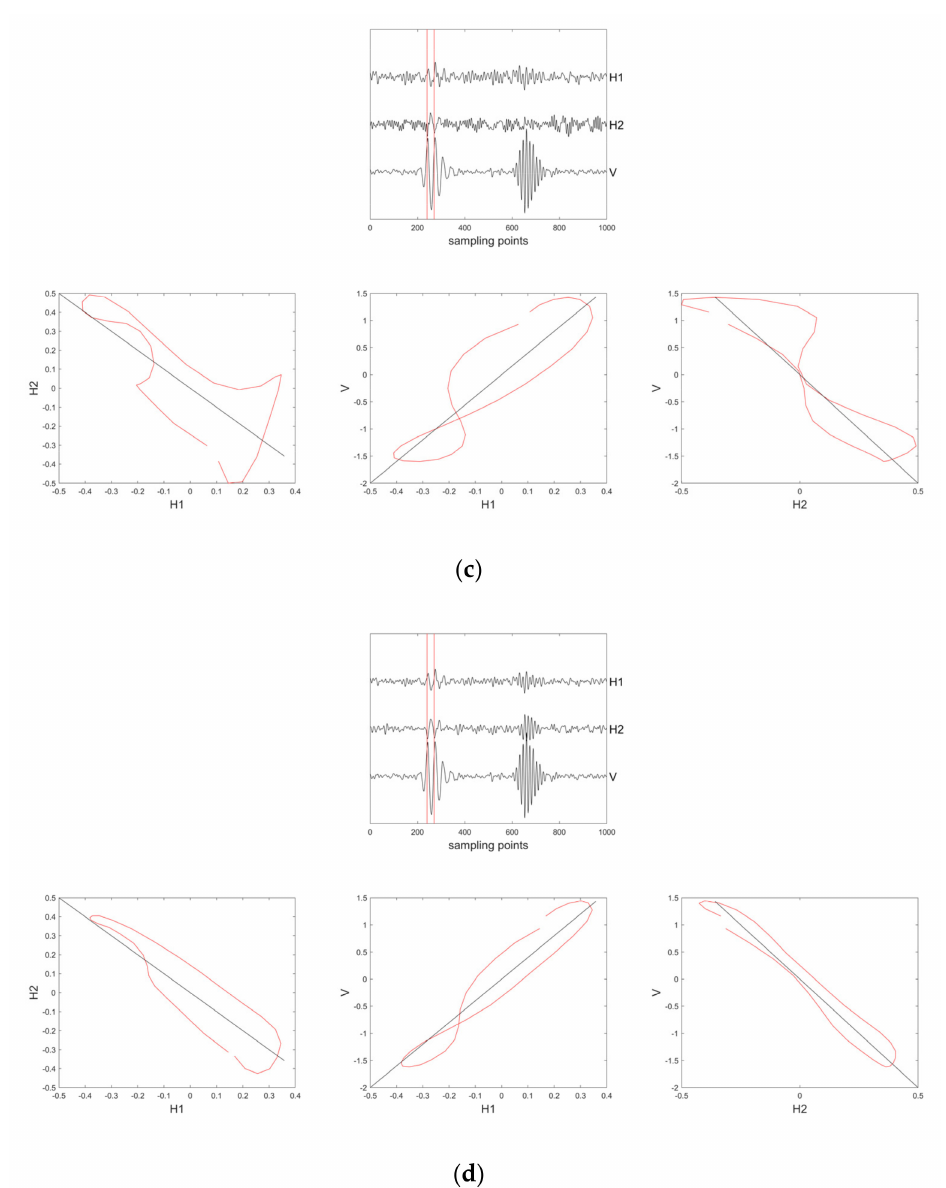
Figure 8. Comparison of hodogram analysis of the synthetic data. ( a ) The synthetic data without noise (the two red lines are the time window of the hodograms) and the hodograms of the three-component data. ( b ) The synthetic data with noise (the two red lines are the time window of the hodograms) and the hodograms of the three-component data (the black lines are hodograms of ( a )). ( c ) The denoising result obtained by using VMD (the two red lines are the time window of the hodograms) and the hodograms of the three-component data (the black lines are hodograms of ( a )). ( d ) The denoising result obtained using re-constrain VMD (the two red lines are the time window of the hodograms) and the hodograms of three-component data (the black lines are the hodograms of ( a